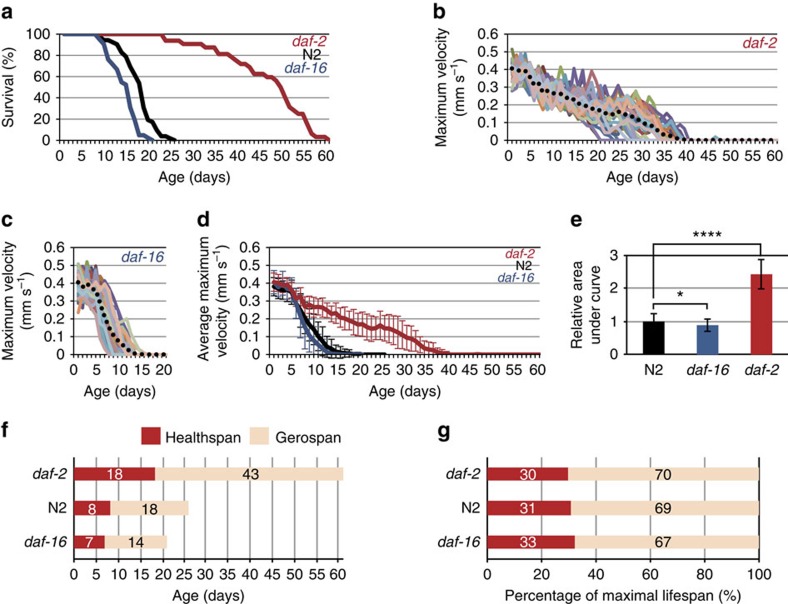
Correlation of MV with lifespan in daf-2 mutants.(a) Age-associated change of survivorship in N2 (wild type) (n=52), daf-2(e1370) (n=32) and daf-16(mu86) (n=42) worms. (b,c) Age-associated change of MVs in daf-2 (b) and daf-16 mutant worms (c). (d) Age-associated change of average MVs in N2 (n=52), daf-2 (n=32) and daf-16 (n=42) mutant worms. Error bars represent s.d. (e) A cumulative difference in physical performance in N2 and daf-16 and daf-2 mutant worms as indicated by area under curves in d. The relative values of area under curves are 1.0±0.2, 0.9±0.2 and 2.4±0.4 for N2, daf-16 and daf-2 worms, respectively. (f) Comparison of healthspan and gerospan in N2, daf-16 and daf-2 worms. Healthspan was defined as ‘the period during which the worm showed >50% maximal functional capacity of wild type'2. Gerospan was defined as ‘the period during which the worm showed <50% maximal functional capacity of wild type'2. (g) The healthspan-to-gerospan ratio normalized to their maximal lifespan in N2, daf-16 and daf-2 worms.